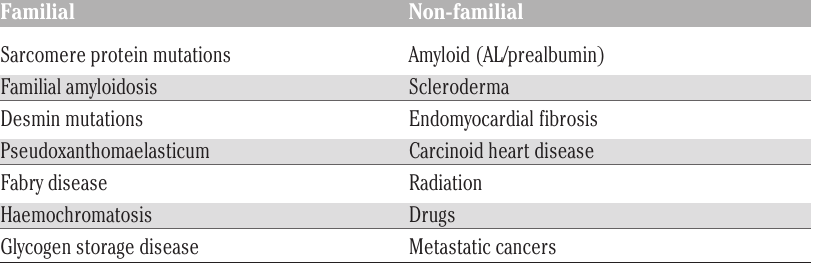
Table 1. Common causes of restrictive